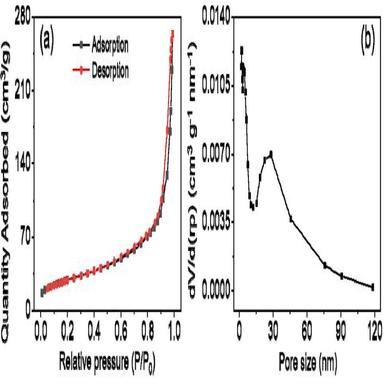
(a) N2 adsorption-desorption isotherms and (b) the pore size distribution of MnCo2O4.5 nanosheets.